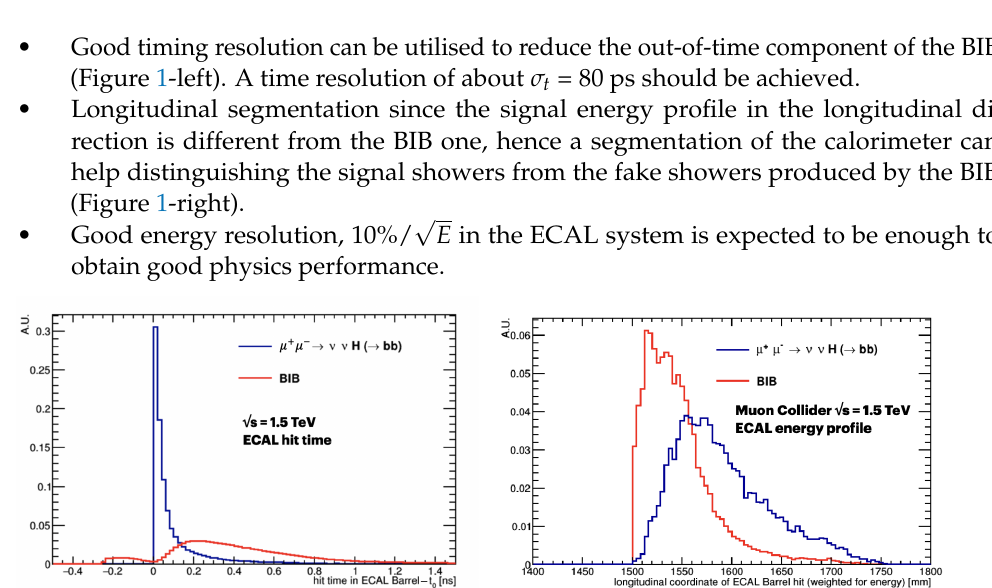
Figure 1. The ( left ) panel shows the time of the ECAL barrel hits with respect to bunch crossing time, for BIB and H → ¯ bb signal. In the ( right ) one the energy distribution of ECAL barrel hits as a function of the distance with respect to the beam axis is presented